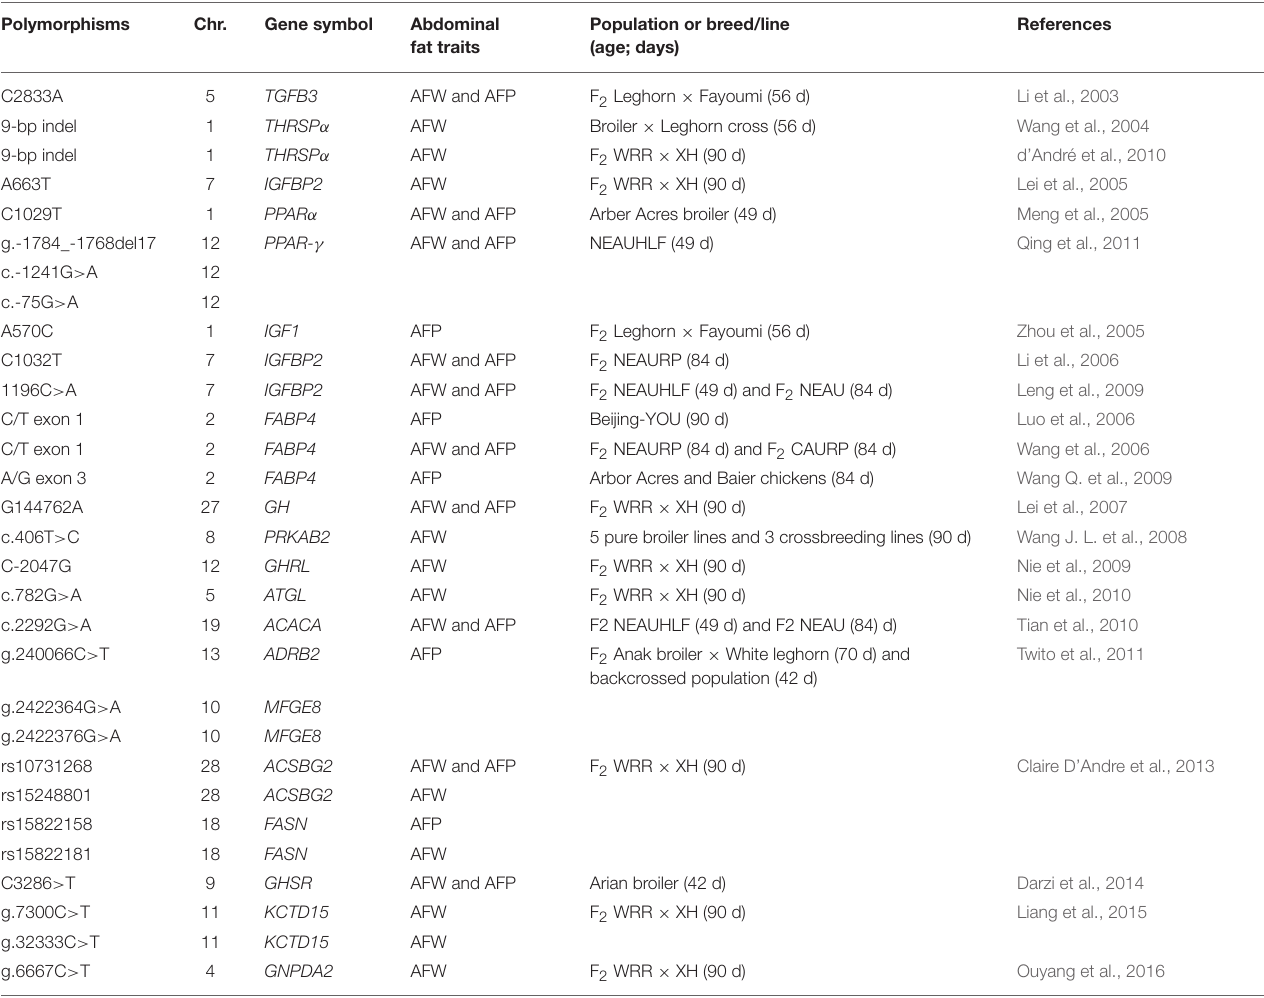
TABLE 2 | DNA polymorphisms significantly associated with chicken abdominal fat traits. Polymorphisms Chr. Gene symbol Abdominal